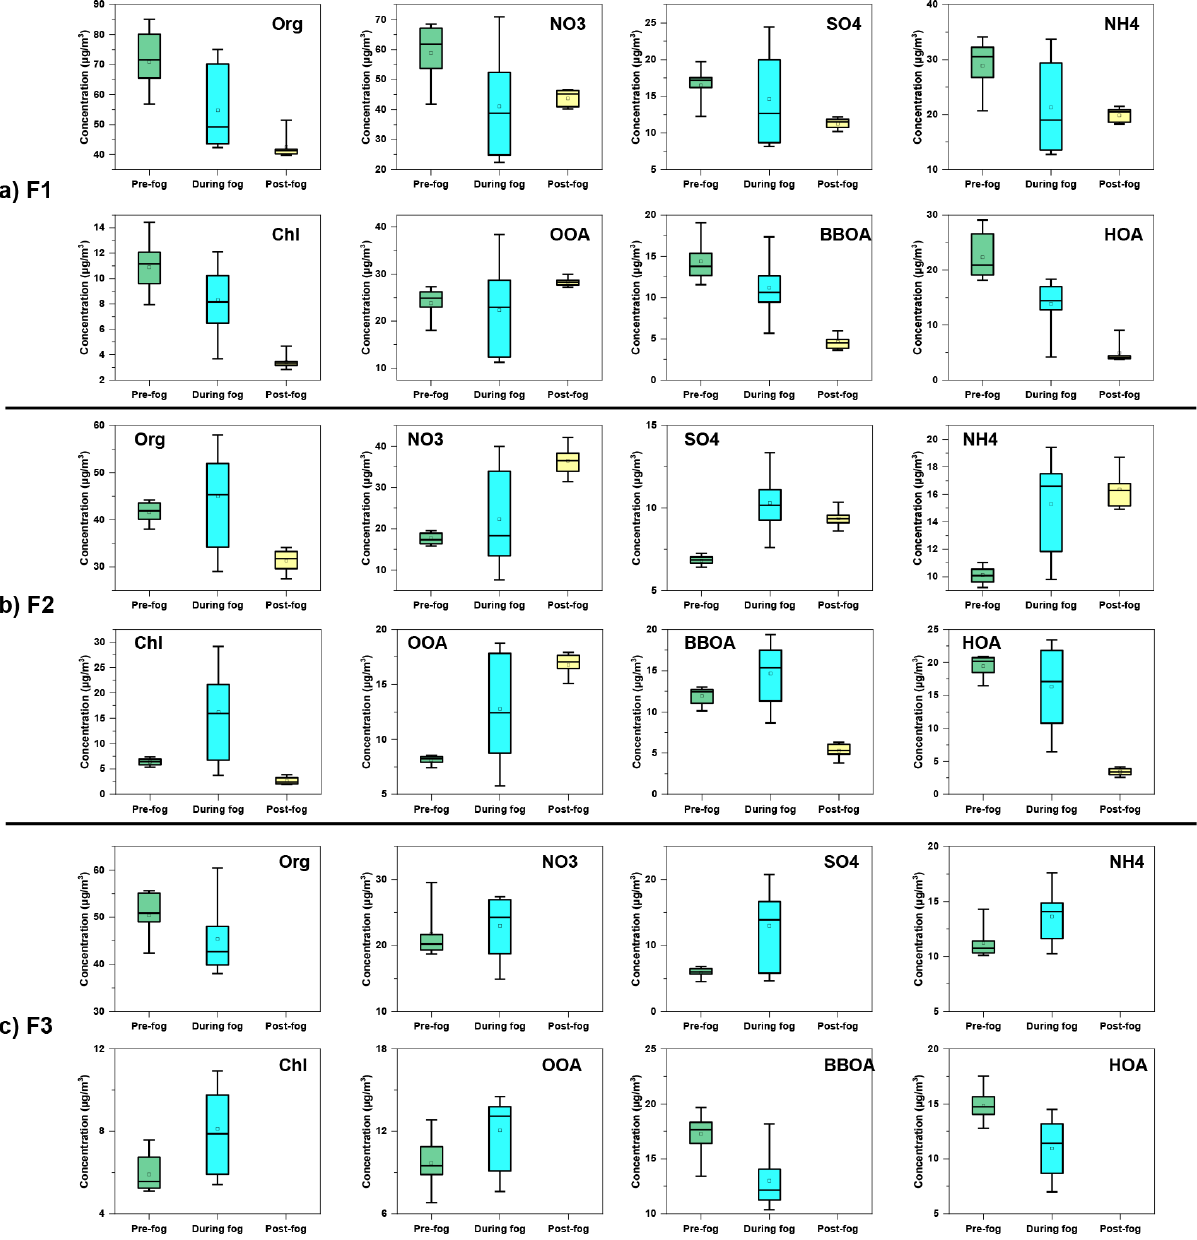
Figure 12. Variation of organics, nitrate, sulfate, ammonium, chloride, OOA, BBOA and HOA concentration during the evolution of (a) F1, (b) F2 and (c)